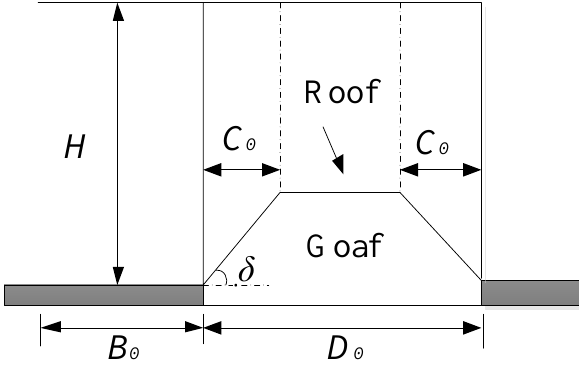
Figure 7. Loading diagram of coal pillar.